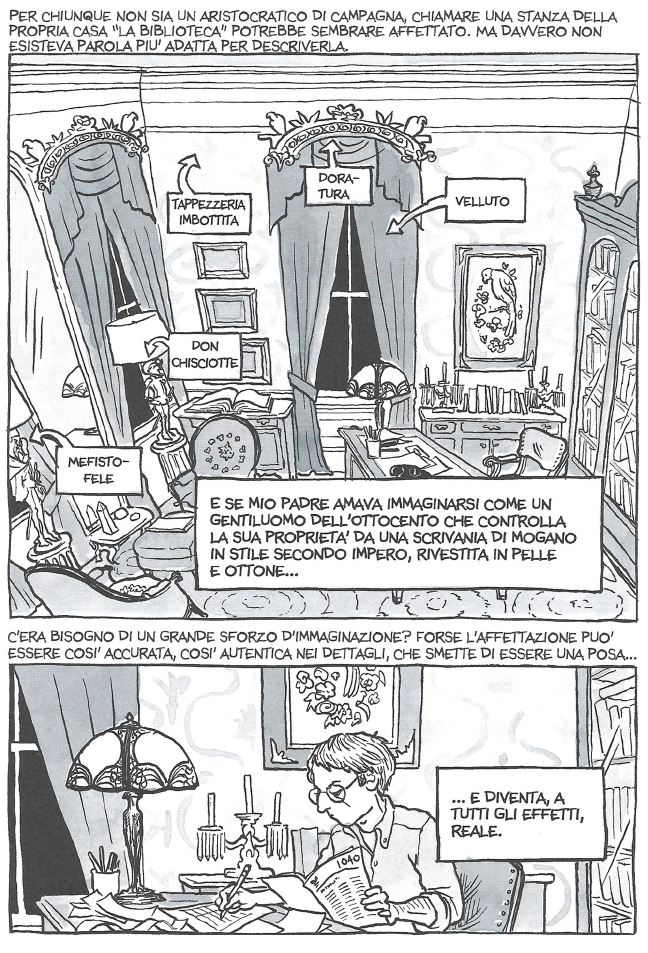
Fig. 6 A page of Fun Home that represents the library of Bruce Bechdel, the real center of the house (Bechdel, 2007, p.